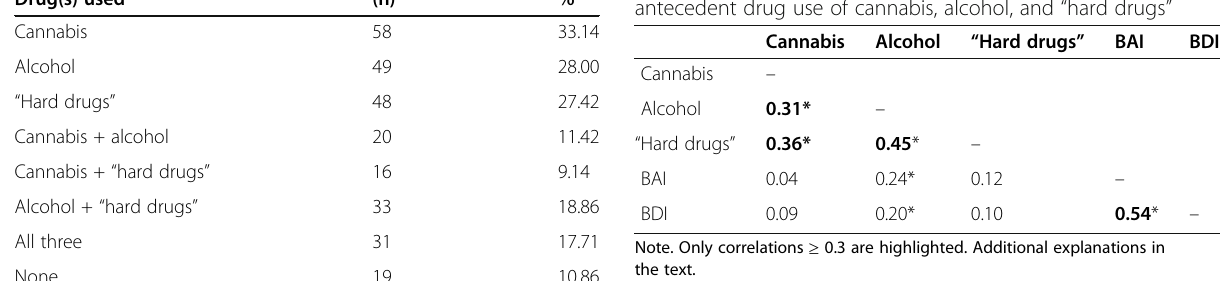
Table 3 Drug use profile one year prior to institutionalization Drug(s) used (n) %